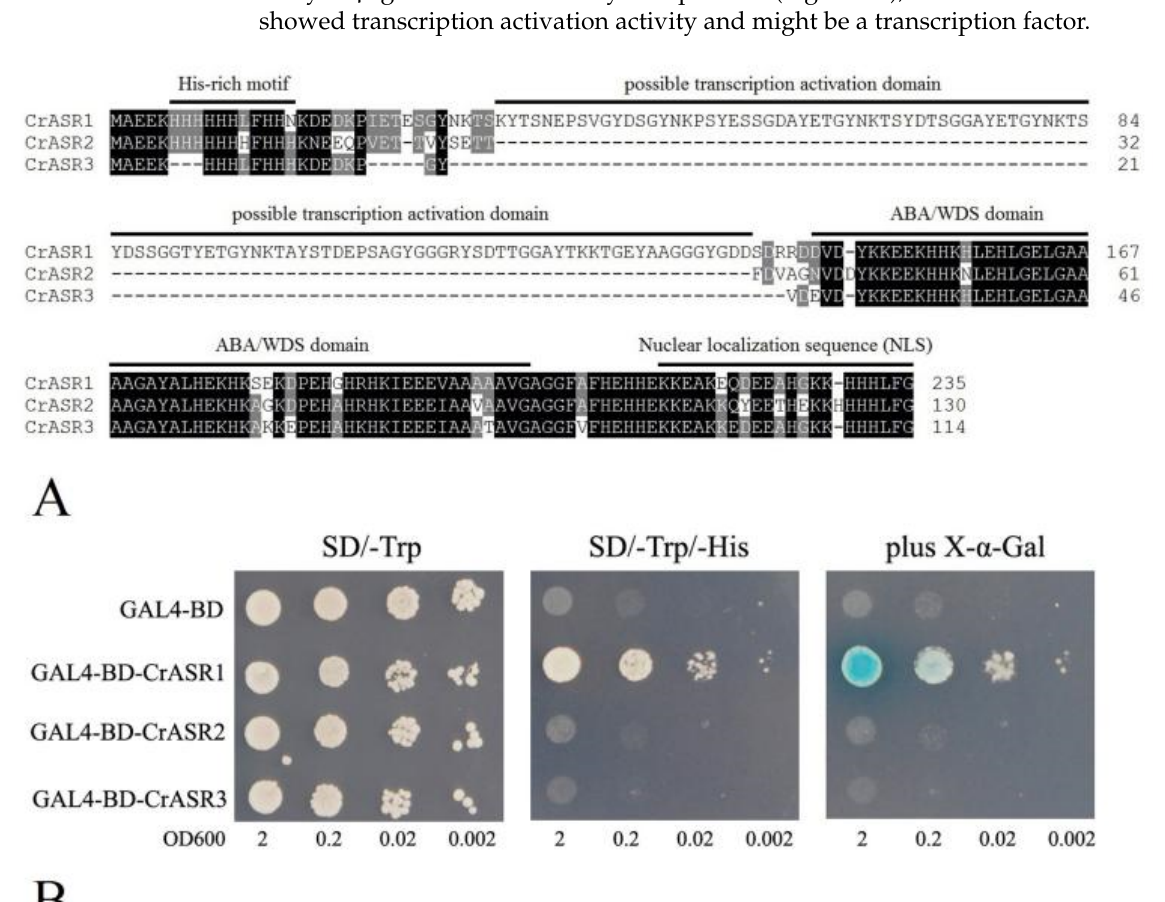
Figure 9. CrASRs sequence alignment and GAL4 DNA binding domain-CrASRs fusion analyses for transactivation activity in yeast. ( A ) Sequence alignment of CrASR1, CrASR2, and CrASR3. The N-terminal His-rich motif, possible transcription activation domain, ABA/WDS domain, and C -terminal nuclear localization sequence were marked with black bold lines. ( B ) The GAL4 DNA binding domain was fused with 3 CrASRs and transformed into the yeast strain AH109 containing the His3 and LacZ reporter genes. Analysis of β -galactosidase activity of the relative yeast strains on plates. The yeast culture (OD600 to 2) was serially diluted to OD600 values of 0.2, 0.02 and 0.002, and then the 2- µ L yeast liquid was spotted onto SD plates and cultured for 2 days at 30 ◦